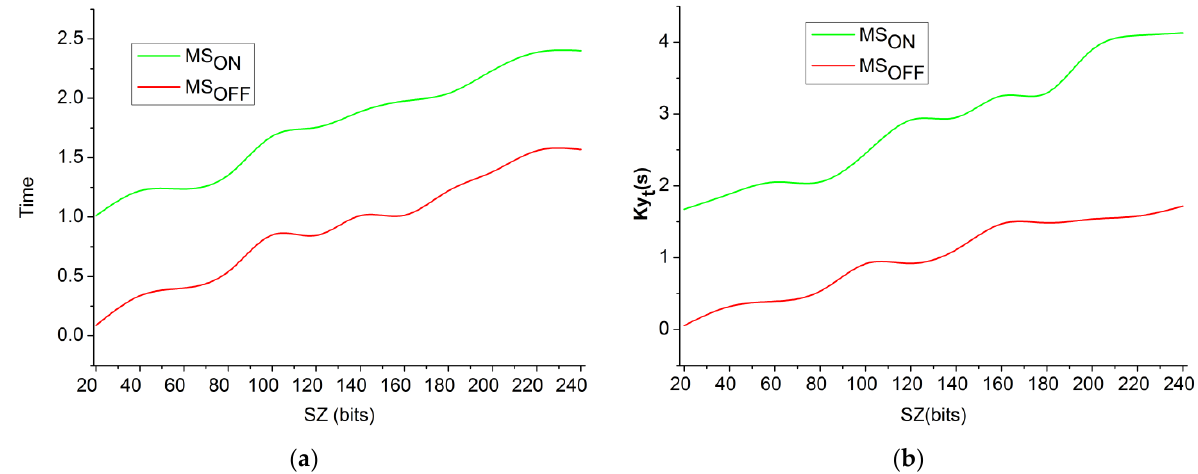
Figure 8. Mutual Time Analysis for ( a ) Different time interval ( b ) Various key.